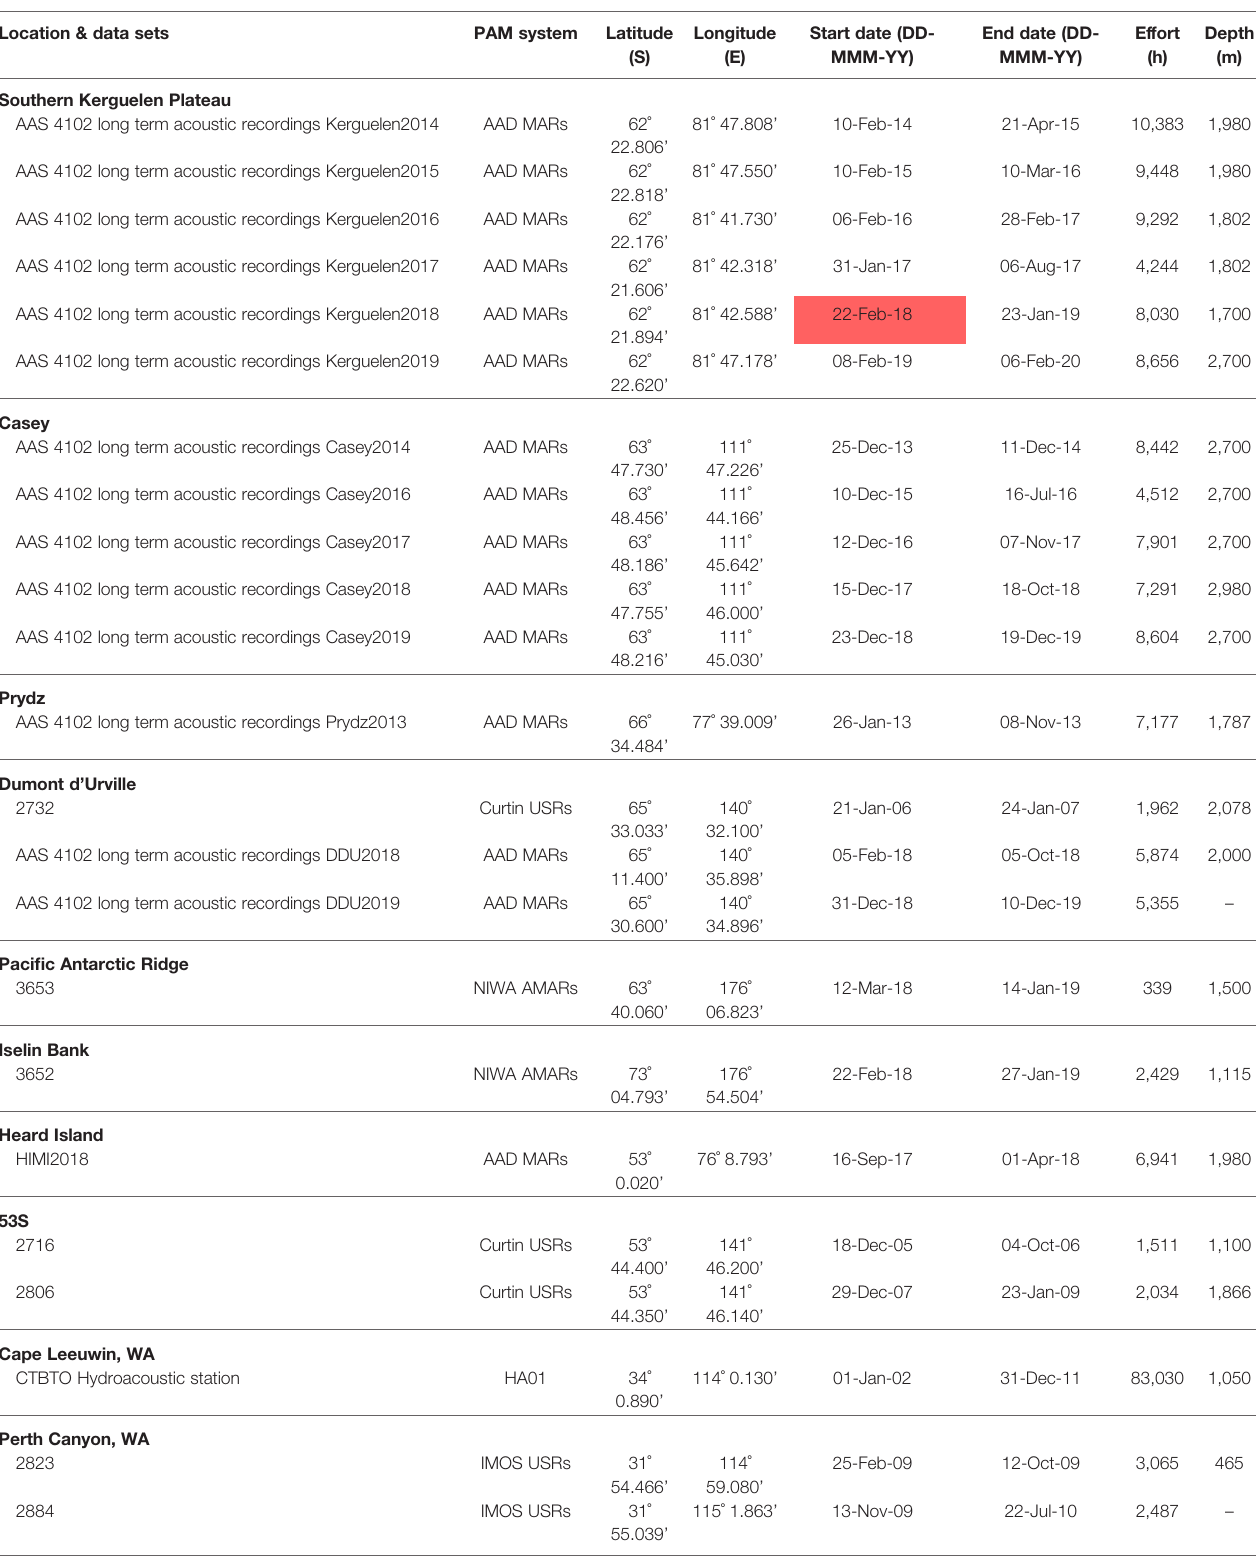
TABLE 1 | Deployment details of the passive acoustic monitoring systems. Location & data